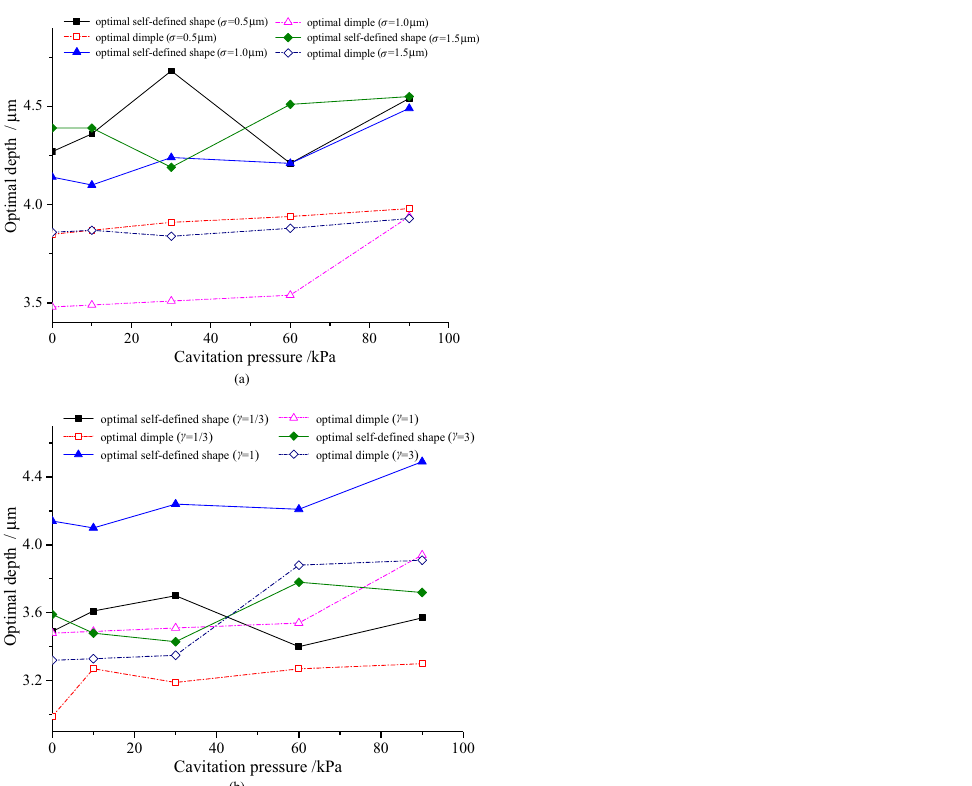
Figure 16. Variation of the optimal depth with